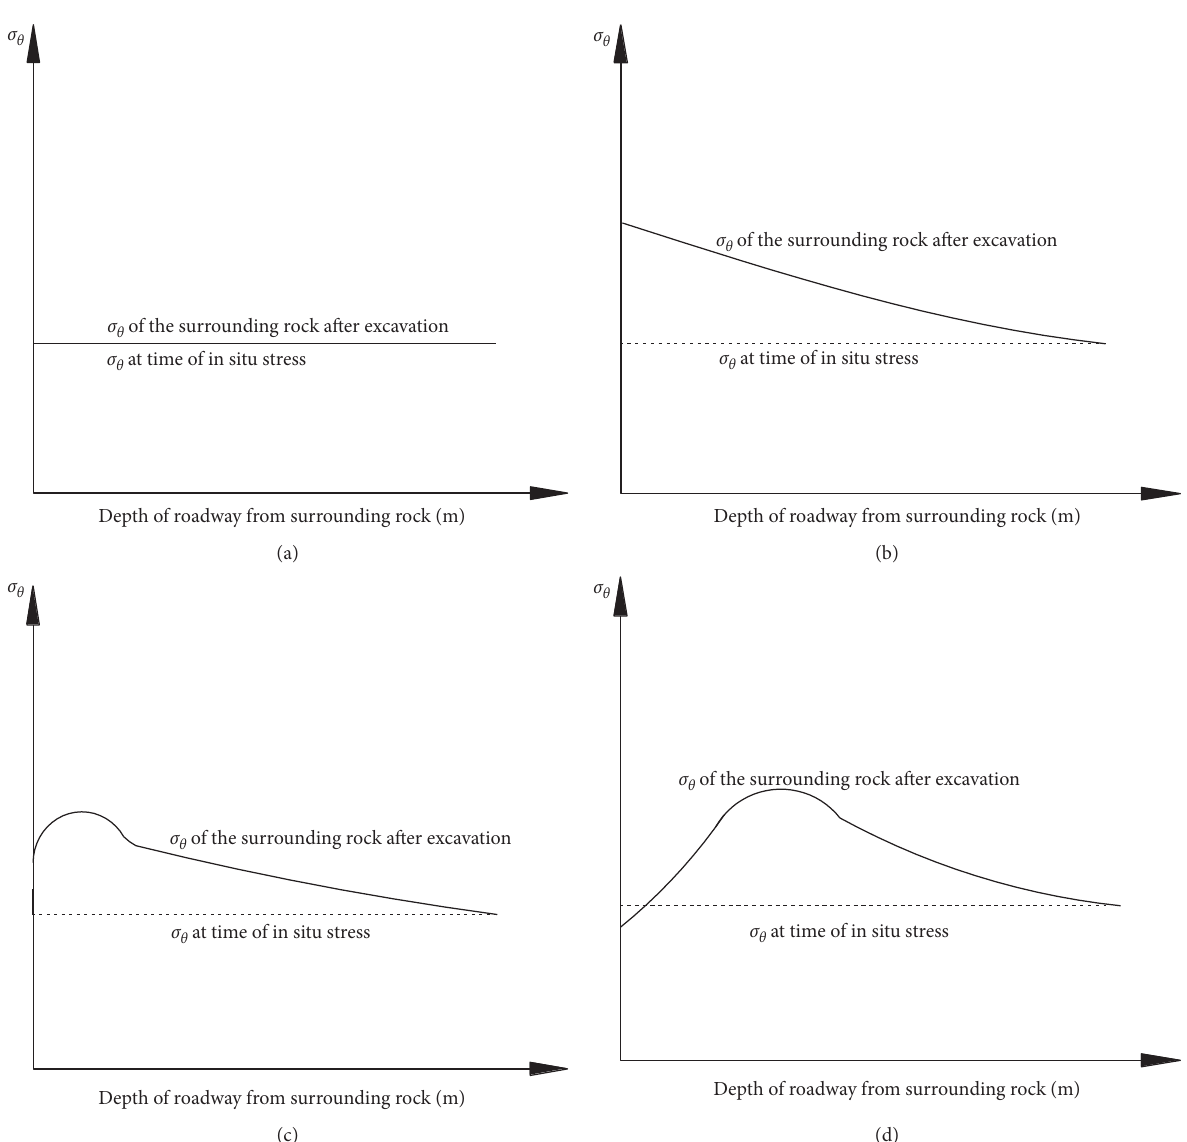
Figure 2: Tangential stress evolution model of rockburst. (a) The initial state. (b) The start state. (c) The intermediate state. (d) The steady